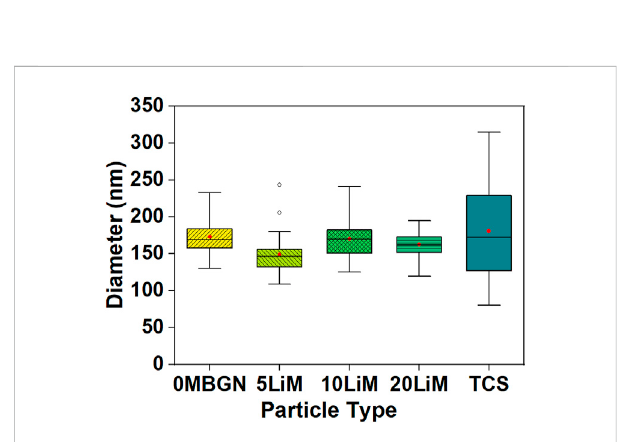
FIGURE 2 The particle size distribution of the as synthesized particles.